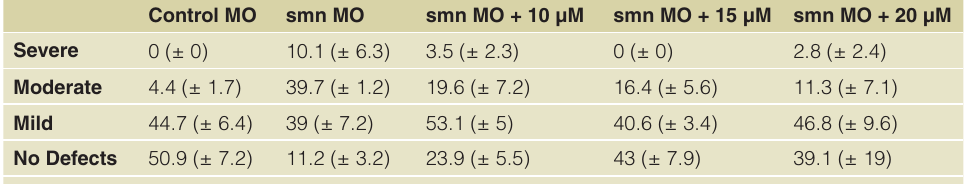
Table 2. Complete dataset for zebrafish experiments.